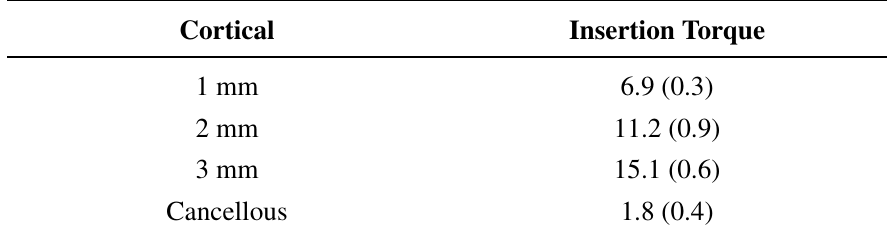
Table 1. Mean insertion torque (N·cm) and standard deviation (SD) of 6 mm mini-implant screw length inserted into polyurethane composite with different cortical thickness.